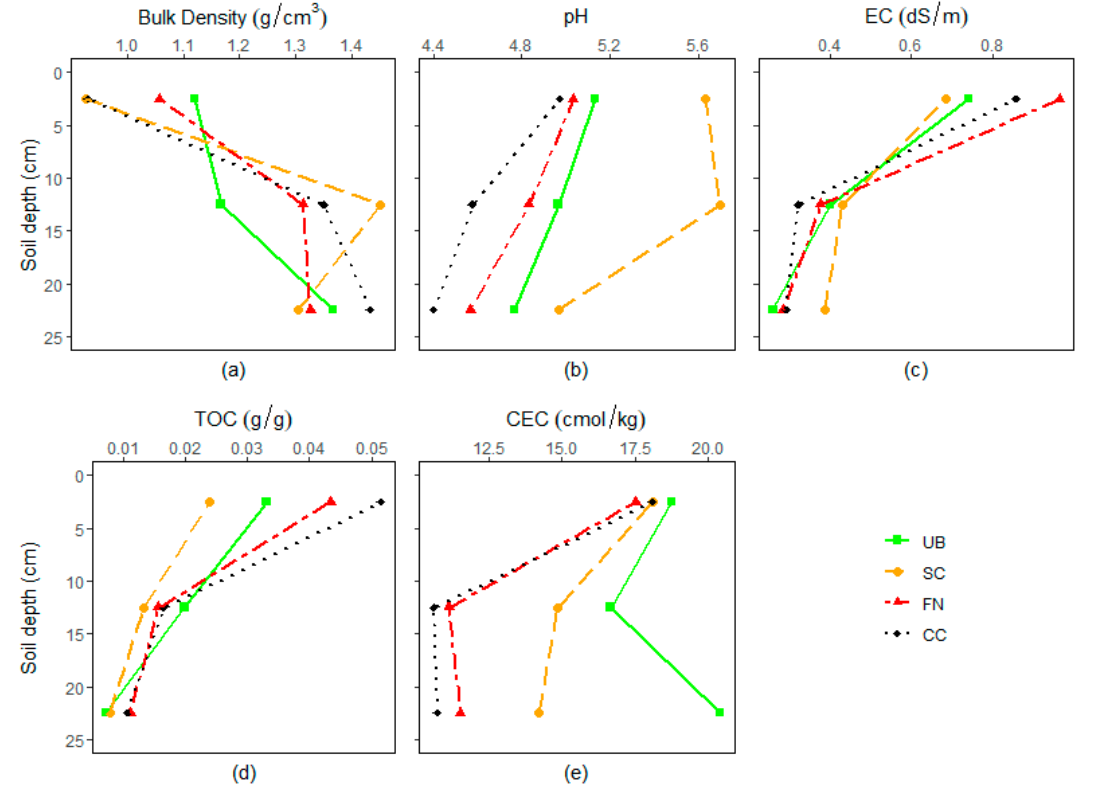
Figure 4. Differences in soil properties (bulk density, pH, EC, TOC, CEC) with vegetation burn severity (UB, SC, FN, CC) and soil depth (0–5 cm, 10–15 cm, 20–25 cm). Soil pH varied but tended to be lower for FN (4.81 ± 0.52) and CC (4.65 ± 0.38) than UB (4.96 ± 0.29) at all depth levels (Figure 4b). The SC, however, had higher pH through- out the soil layers (5.43 ± 0.75) than UB. The magnitude of difference varied with burn severity.